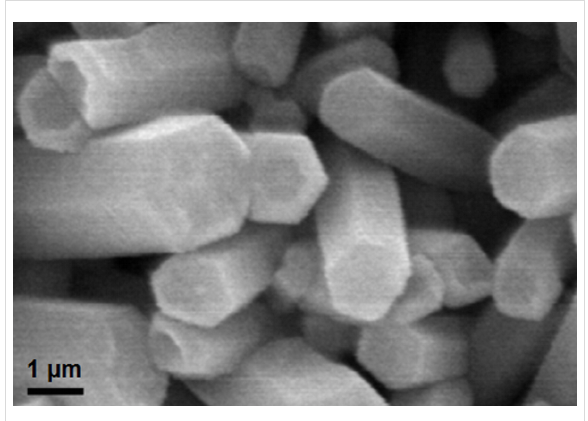
Figure 5: A typical scanning electron micrograph showing the ZnO nanorods grown using microwave irradiation in a reaction bath containing 10.0 mM zinc nitrate and hexamethylenetetramine for 10 h; structural defects can be observed especially on the polar face.